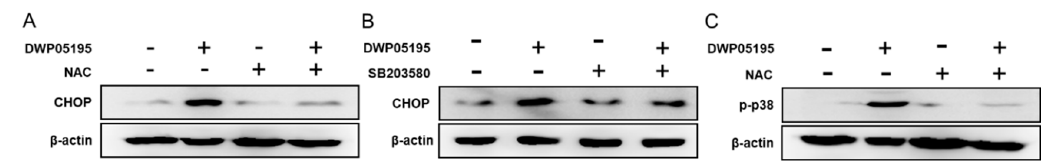
Figure 7. The involvement of ROS levels and p38 activation in CHOP expression. ( A ) A2780 cells were pre-treated with antioxidant NAC (7.5 mM) or ( B ) SB203580 (20 μ M), and then treated with DWP05195 (15 μ M) for 24 h. CHOP levels were determined by Western blotting. ( C ) A2780 cells were